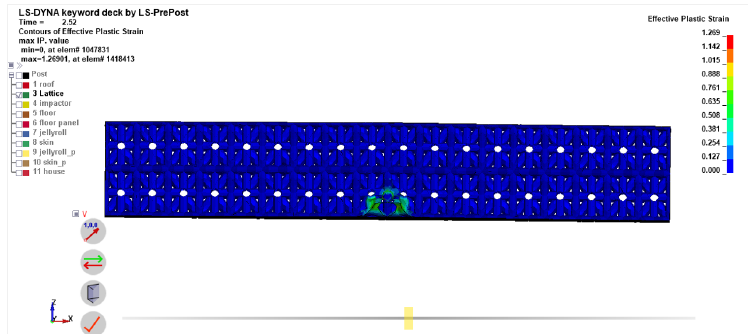
Figure 22. Plastic Deformation of The Configuration #3 Lattice